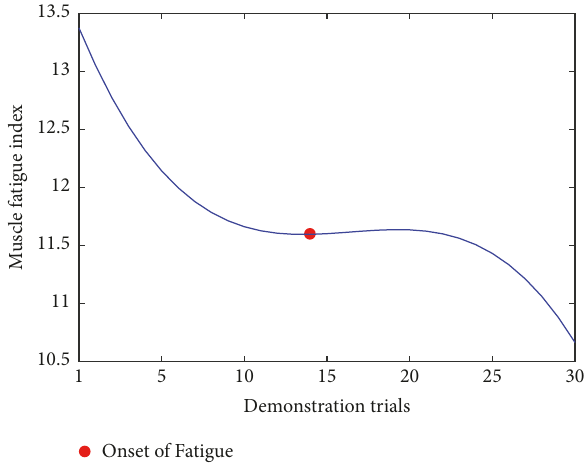
Figure 6: The smoothed curve of the proposed fatigue-related features (average instantaneous amplitude of sEMG signal) across all trials during the human demonstration to